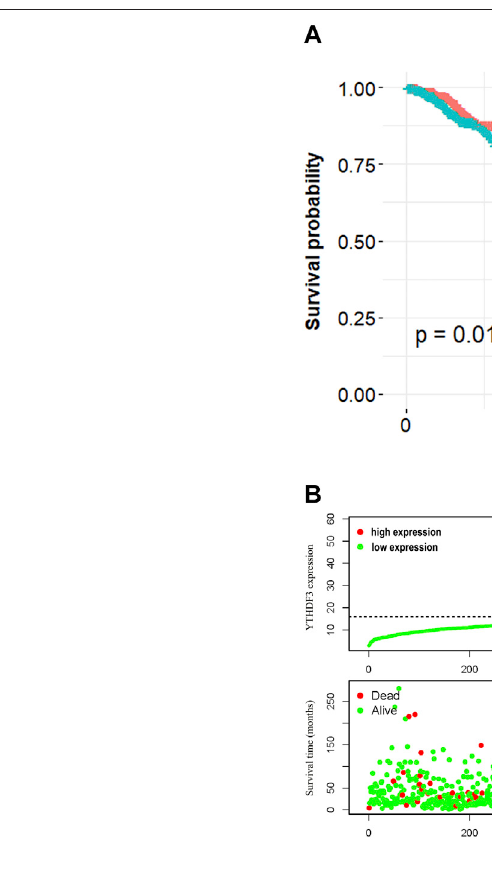
Frontiers in Molecular Biosciences |